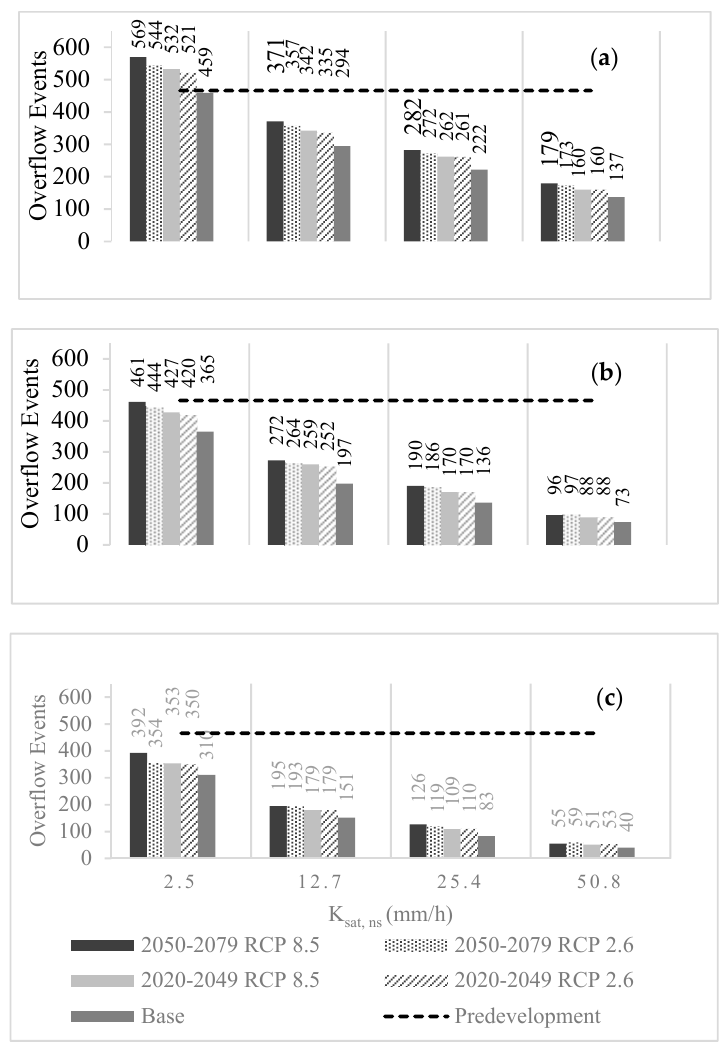
Figure 1. Cumulative overflow events for each climate scenario based on K sat, ns for bioinfiltration facilities with: ( a ) 76 mm of ponding, ( b ) 152 cm of ponding, and ( c ) 229 mm of ponding.